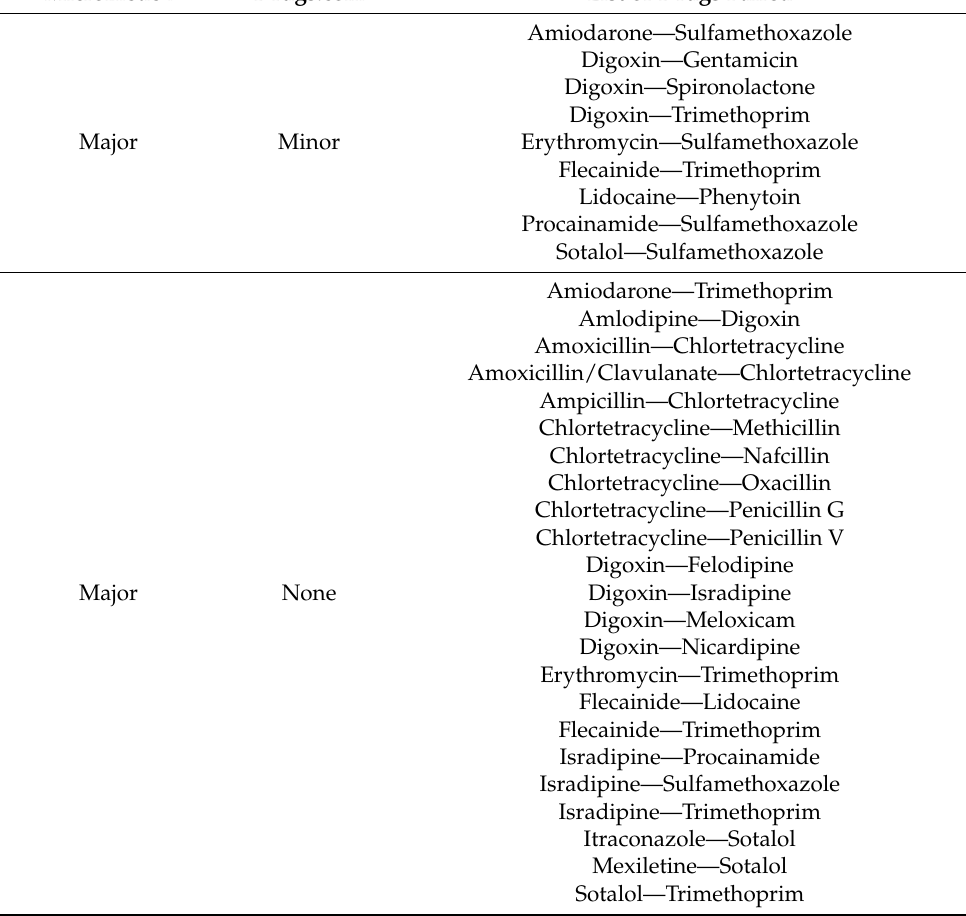
Table 2. Different results between the two databases in the identification of potential DDIs.